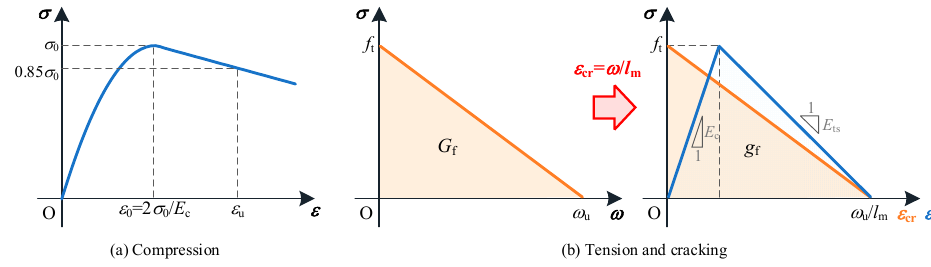
Figure 7. Uniaxial constitutive law for concrete.